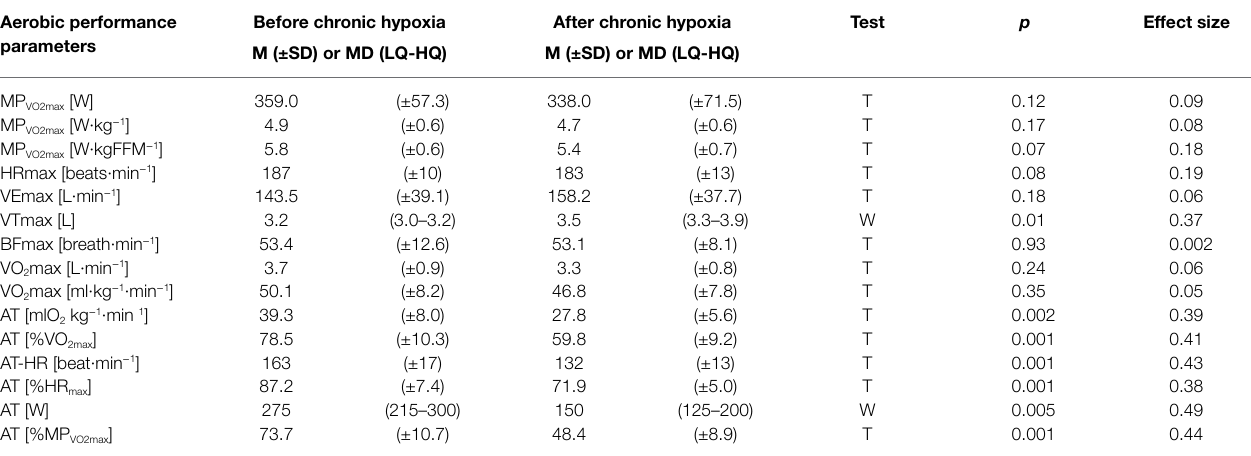
TABLE 1 | Parameters of aerobic performance measured before and after 1 month at very high altitude (mean altitude of 4,900 ± 60 m). Aerobic performance